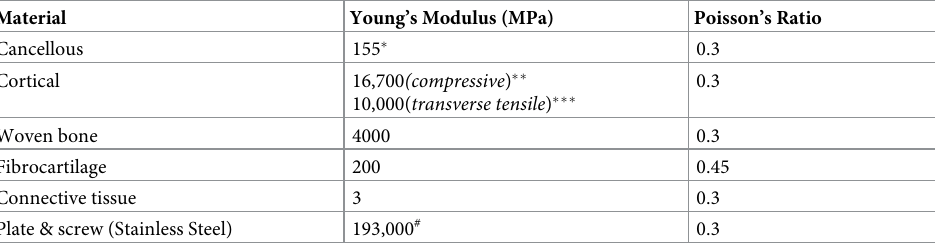
Table 1. Material Property data based on ASTM D638 ��� , D695 �� , D1621 � & 308#.